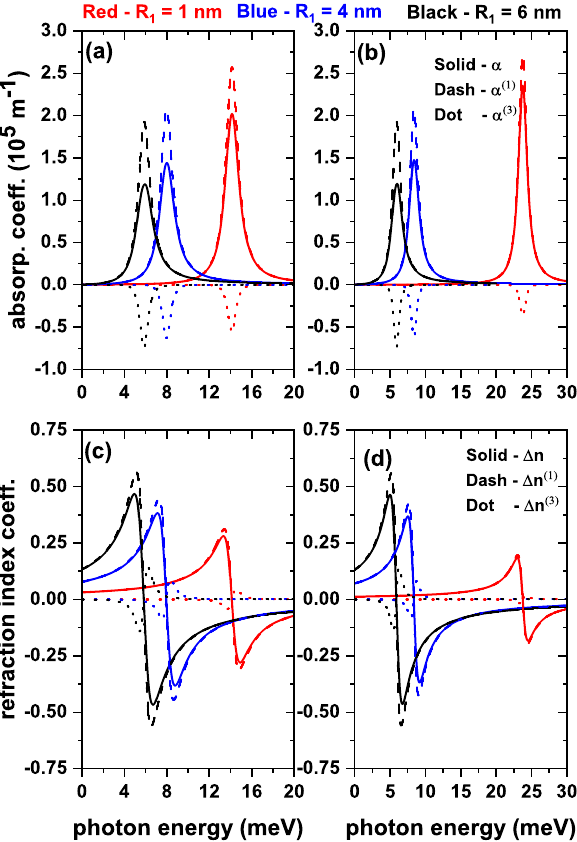
Figure 8. The total (solid line), linear (dashed line), and nonlinear (dotted line) optical absorption coefficient ( a , b ), and the total (solid line), linear (dashed line), and nonlinear (dotted line) relative changes in the refractive index coefficient ( c , d ) as functions of the incident photon energy in a ZnS/CdS/ZnS spherical core/shell/shell quantum dot, for three values of the internal radius: 1 nm (red line), 4 nm (blue line), and 6 nm (black line). Results are without ( a , c ) and with ( b , d ) donor impurity at the center of the dot. Calculations are with R 2 = 11nm and R 3 = 12nm. The optical transition is between the states | 1 (cid:105) → | 2 (cid:105) , with m = 0 and without external electric and magnetic field